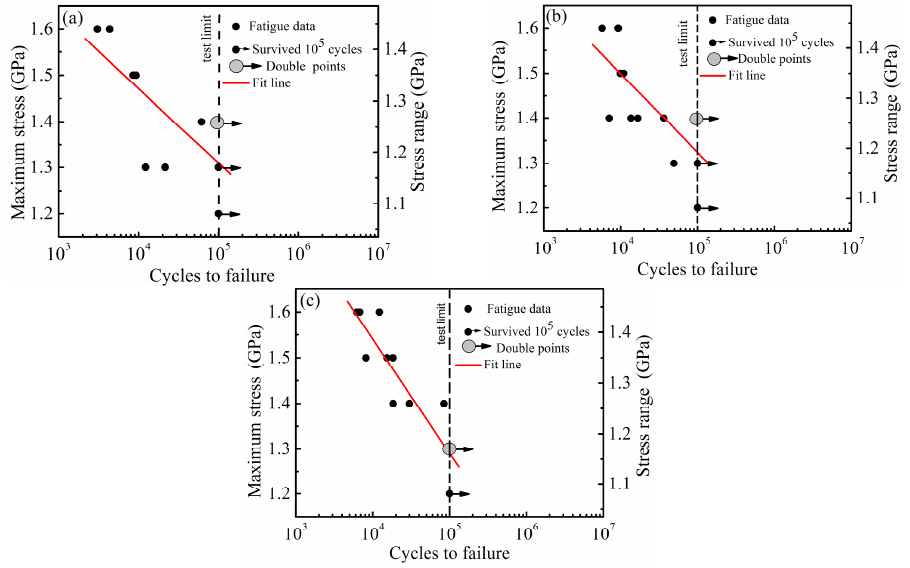
Figure 4. S – N curves obtained by high-cycle, push–pull fatigue tests of isothermally transformed samples. ( a ) A1; ( b ) A2; ( c ) A3. samples. ( a ) A1; ( b ) A2; ( c )